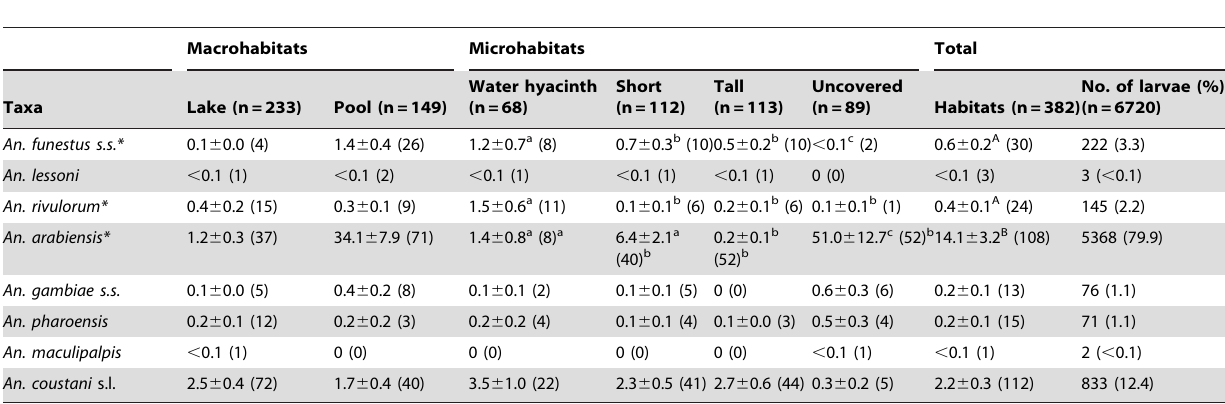
Table 5. Mean densities 6 SE (per site) and occurrences of anopheline larvae sampled from the lake and adjacent habitats, and from microhabitats categorized based on vegetation cover at each sampling site in